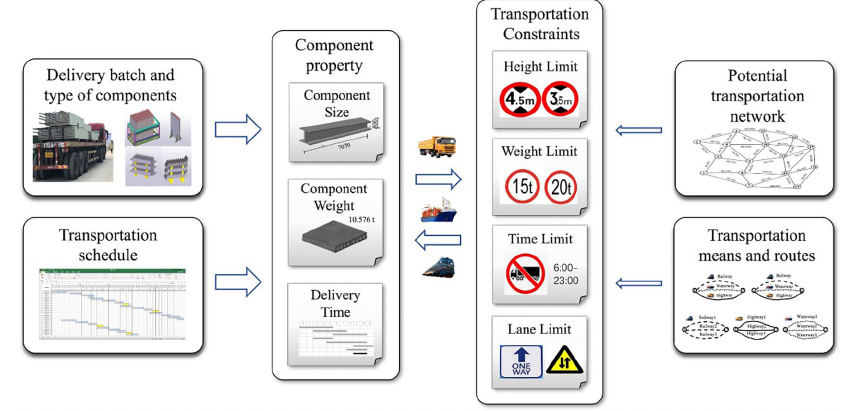
Figure 1. Disruptions on the PCSC due to various transportation